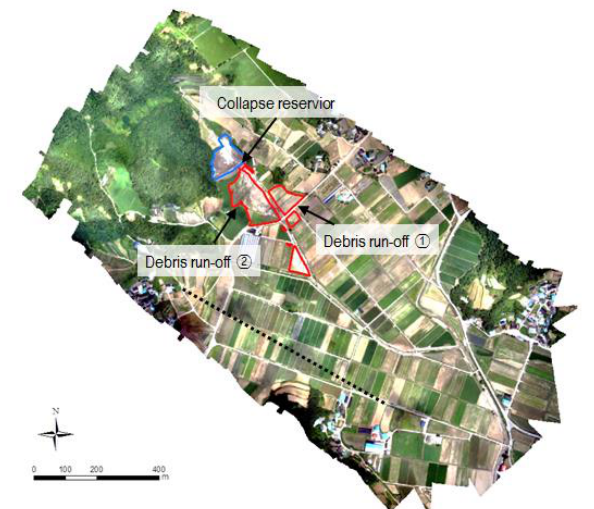
Figure. 7. Flood damage analysis by reservoir collapse